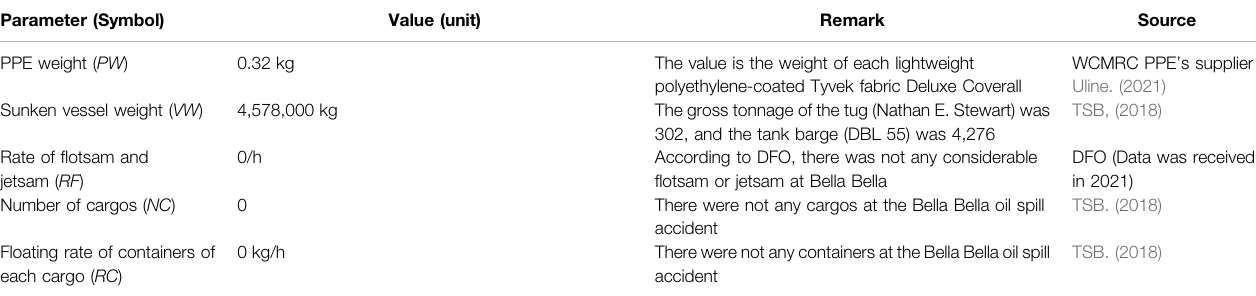
TABLE 2 | ( Continued ) Bella Bella oil spill data and assumptions for the system dynamics model